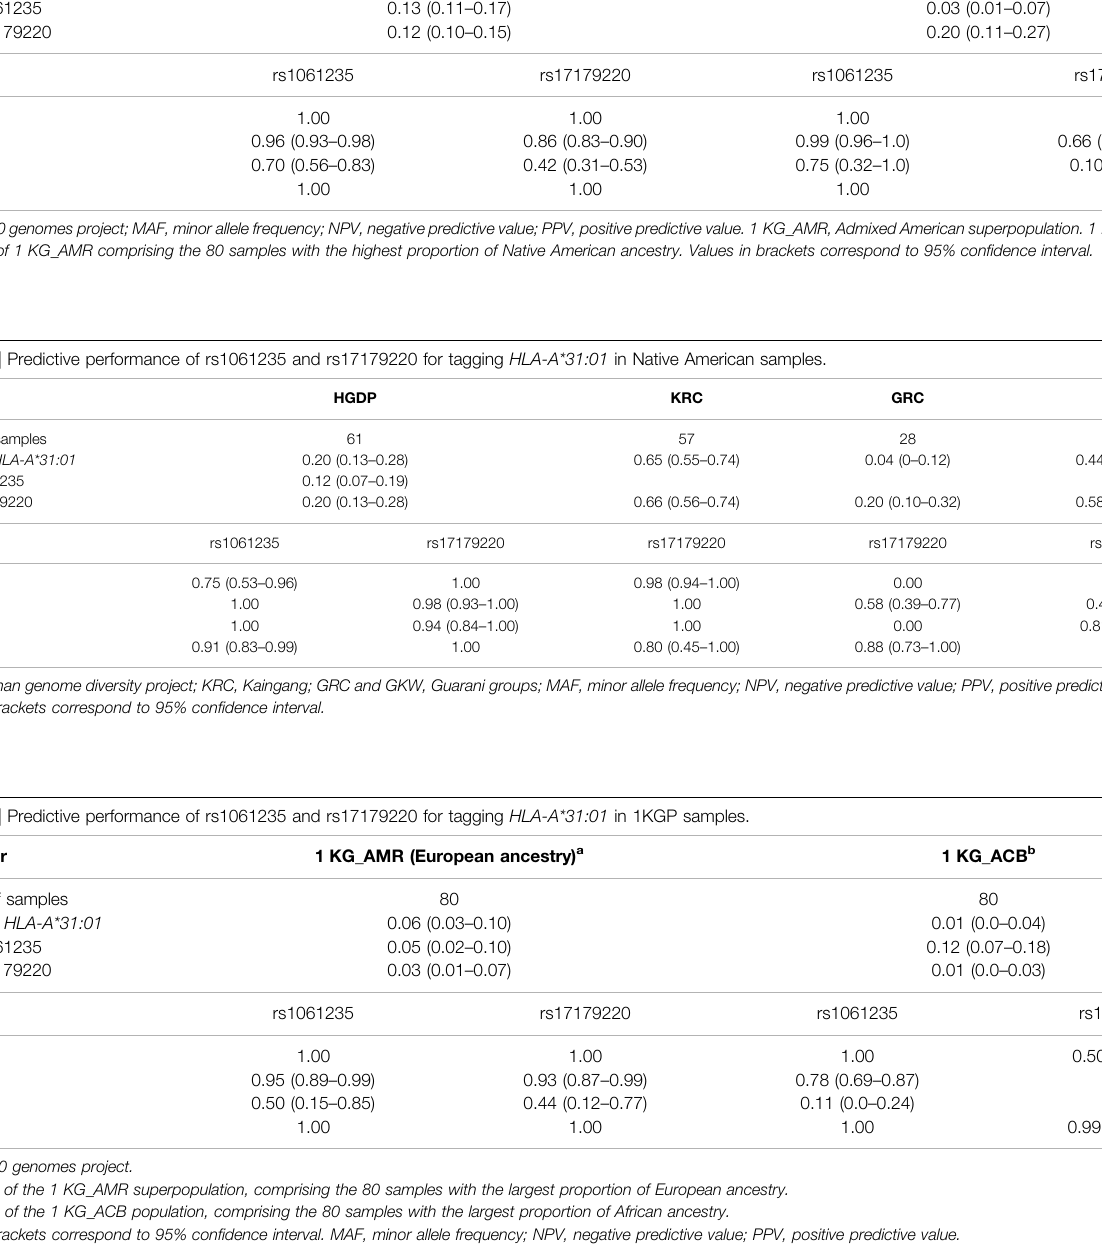
TABLE 1 | Predictive performance of rs1061235 and rs17179220 for tagging HLA-A*31:01 in 1KGP samples. Parameter Number of samples